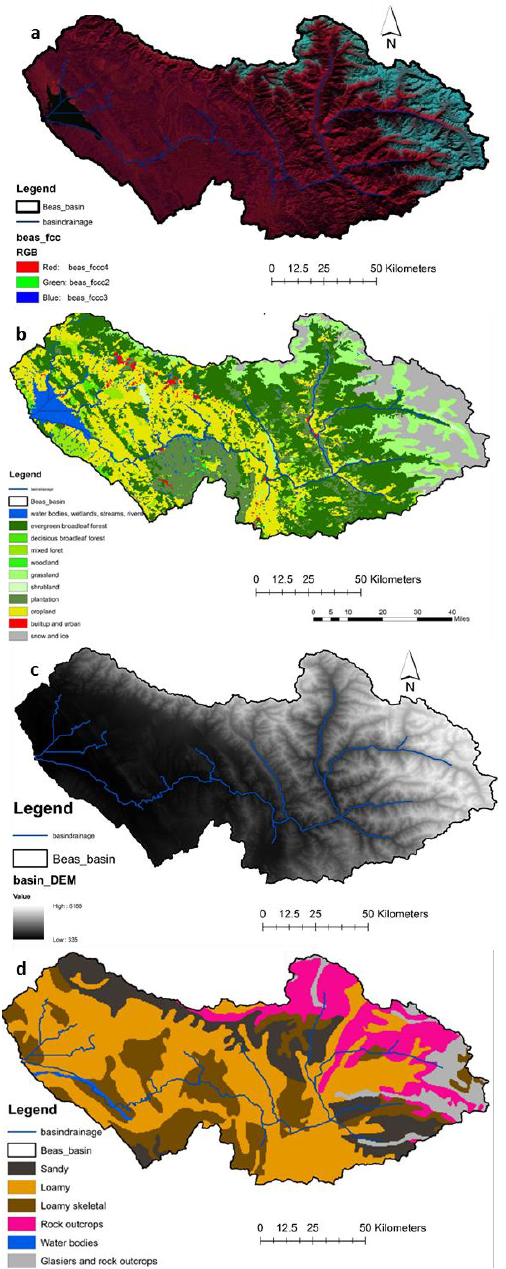
Figure 2a: False color composite image of Beas basin, b: LULC map, c: DEM map, and d: soil map of study area.